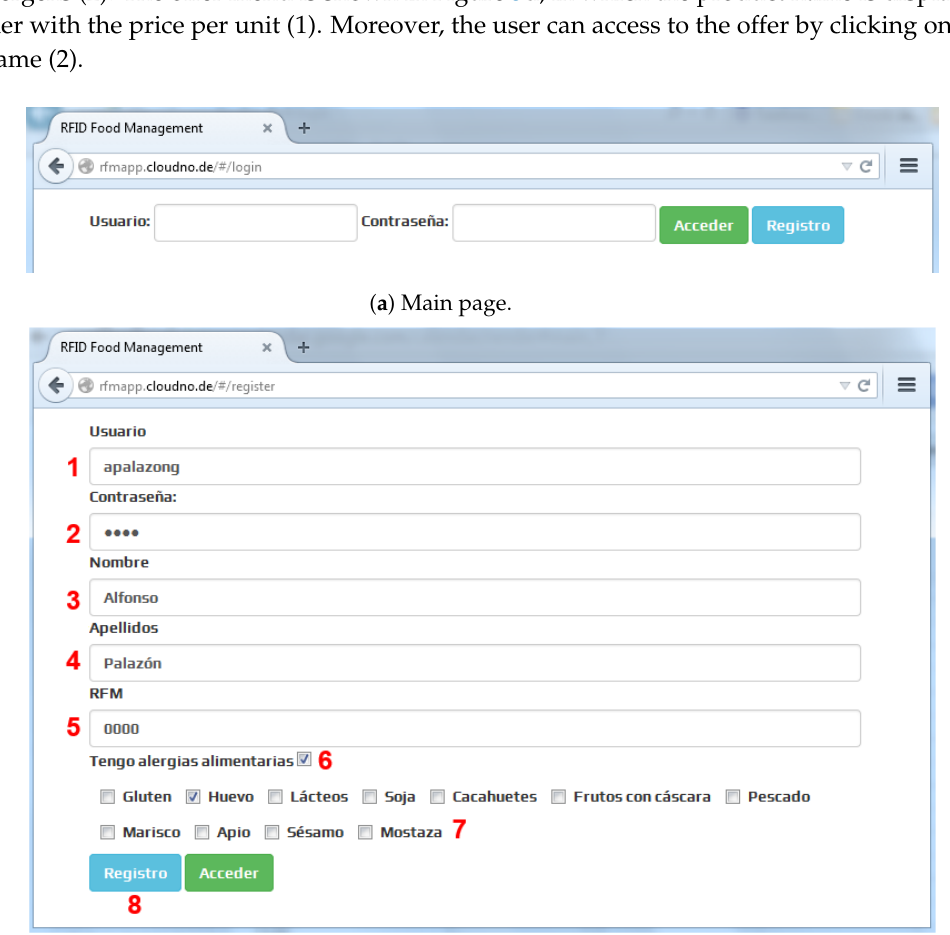
Figure 3. Main page and registration